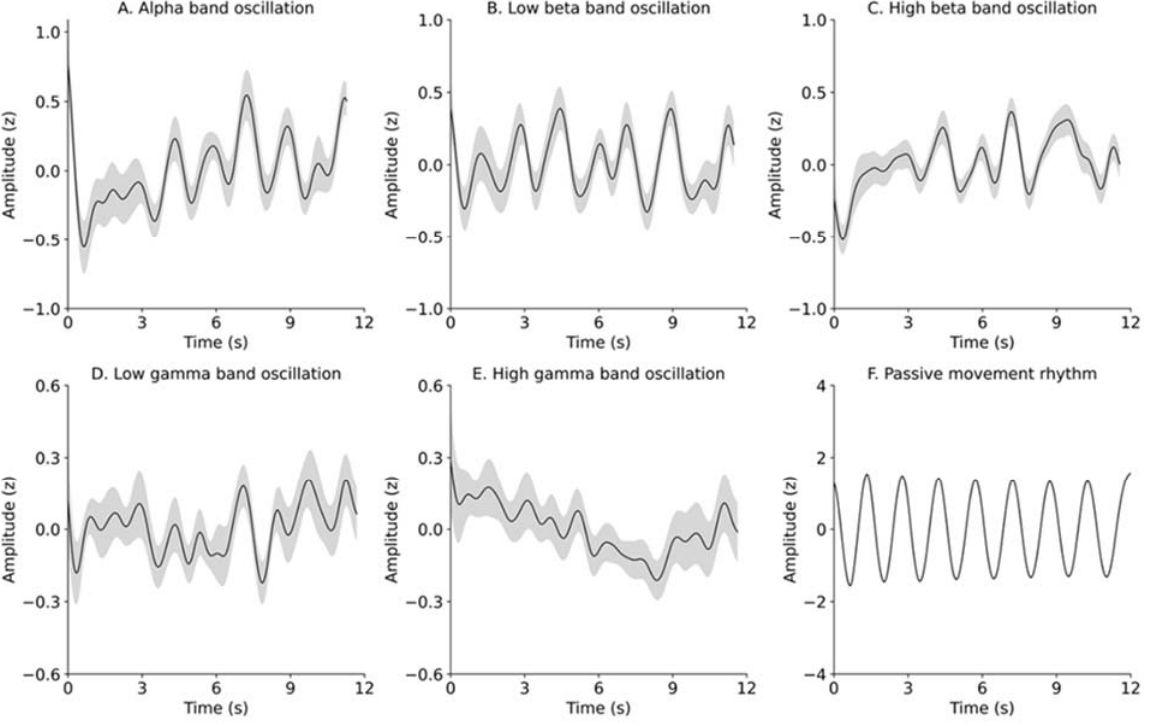
Figure 2. Time courses of changes in the mean ± SEM of alpha ( A ), low ‐ beta ( B ), high ‐ beta ( C ), low ‐ gamma ( D ), or high ‐ gamma ( E ) oscillations, and in the mean ± SEM of the elbow angle ( F ). Black lines and gray zones denote the mean and SEM of alpha ( A ), low ‐ beta ( B ), high ‐ beta ( C ), low ‐ gamma ( D ), or high ‐ gamma ( E ) oscillations. Black dashed lines and gray zones denote the mean and SEM, respectively.